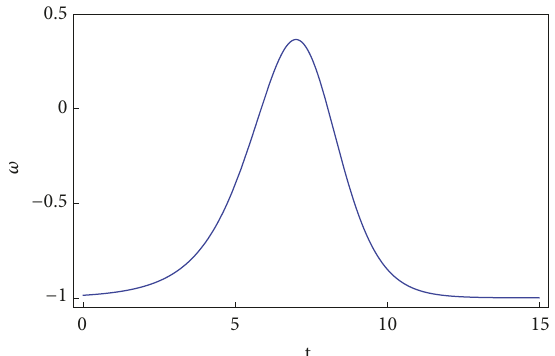
Figure 6: Time evolution of the analytical EoS parameter derived from our two-field model. The picture was depicted with 𝑏 2 = 2 and = −8 . There we observe two expansion eras where 𝜔 ≈ −1 and 𝑡 0 that the parameter has maximum close to 𝜔 ≈ 1/3